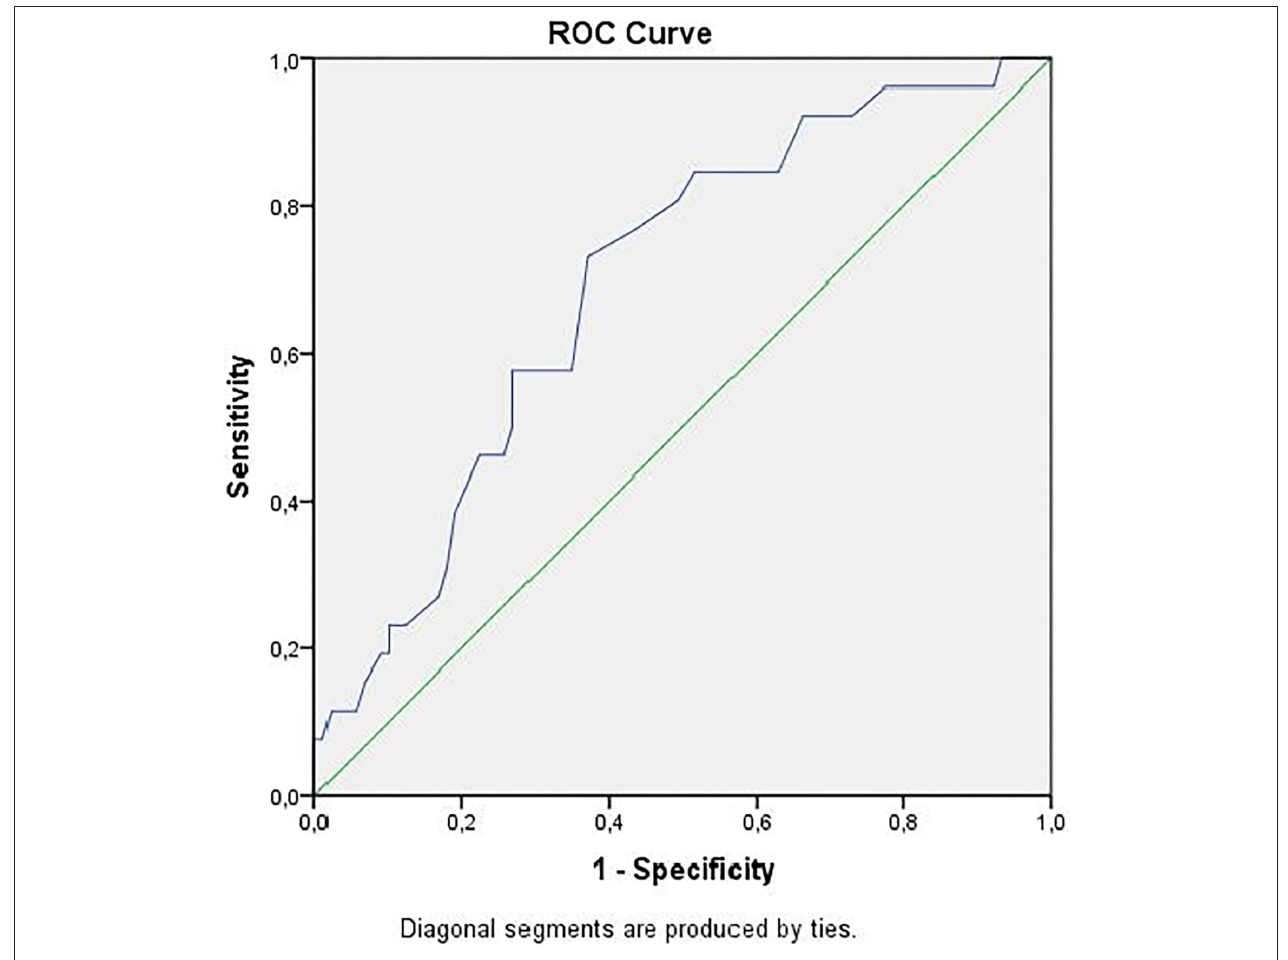
FIGURE 5 | ROC curve of mean platelet volume for intensive care unit transfer state when D-dimer ≥ 1.0 mg/L. ROC, receiver operating